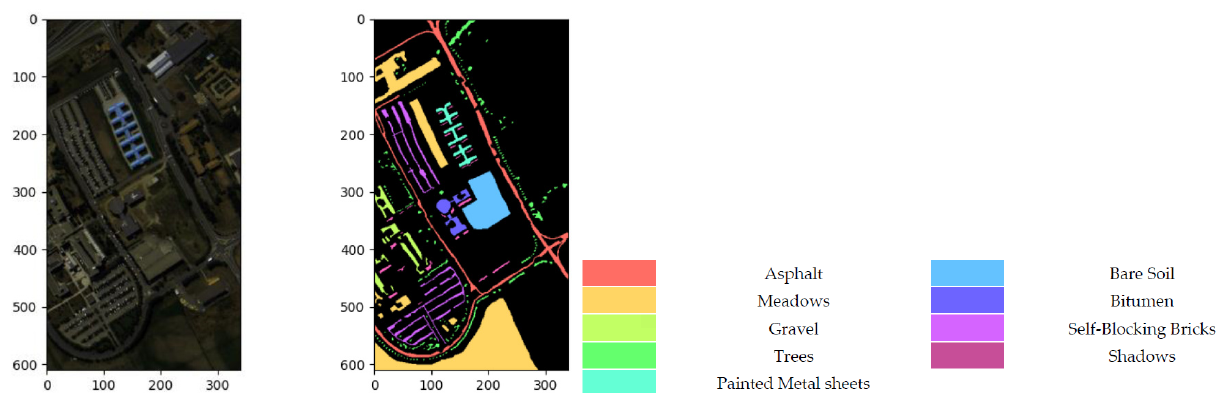
Figure 6. Pseudo-color image (R: 60, G: 30, B: 2) and ground truth of Pavia University dataset.